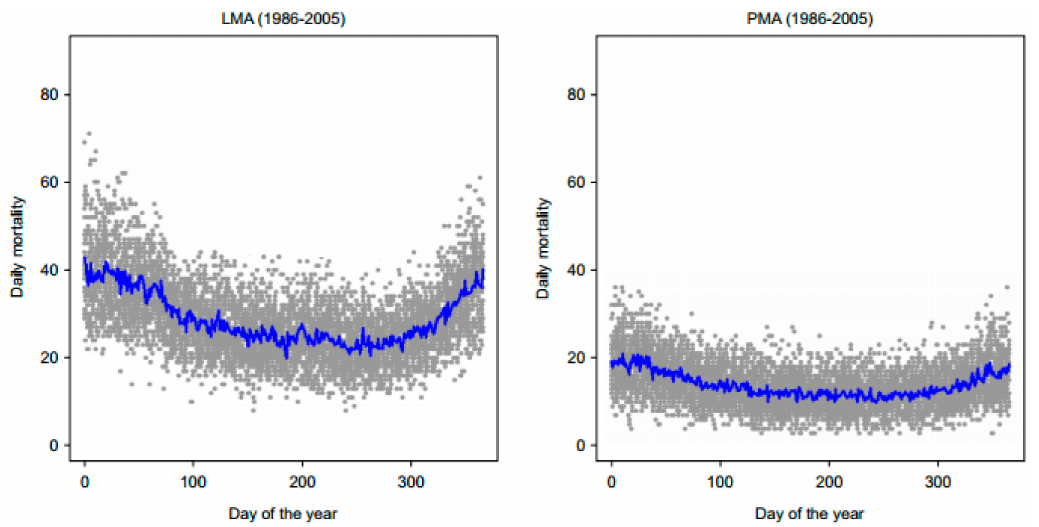
Figure 1. Seasonal distribution of daily mortality in Lisbon metropolitan area (LMA) and Porto metropolitan area (PMA). The grey dots are the actual number of deaths in each day of the year during the period from 1986 to 2005, and the blue line is the average daily mortality per day of the year projected into the